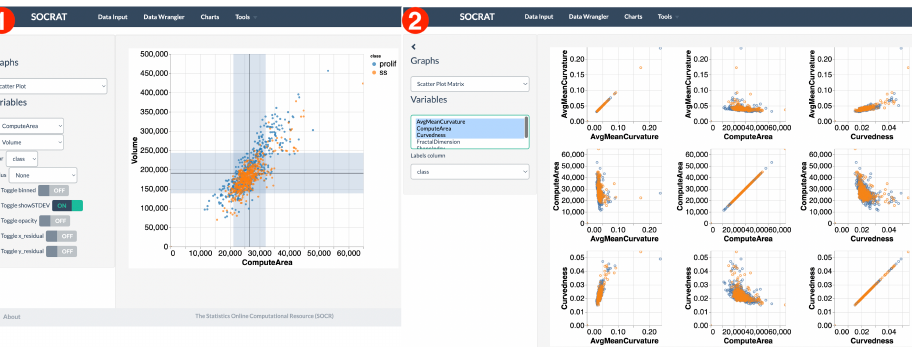
Figure 10. Multivariate interactive visualizations of cell morphology measures: ( 1 ) scatter plot demonstrating linear relationship between cell nucleus volume and surface area; ( 2 ) scatter plot matrix showing relationship between various nuclear morphology features.